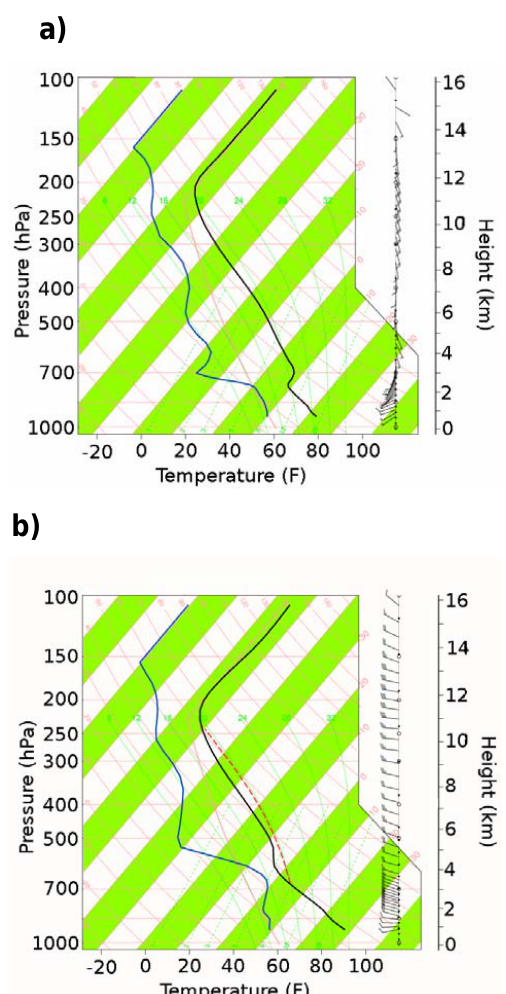
Fig. 4. Sample soundings from WRF-Chem (PC_PLR) at example locations of a) low (1.1 km) and b) high (5.4 km) injection heights. Temperature and dew point are in black and blue, respectively. Convective Available Potential Energy (CAPE) is indicated by a dashed red line.